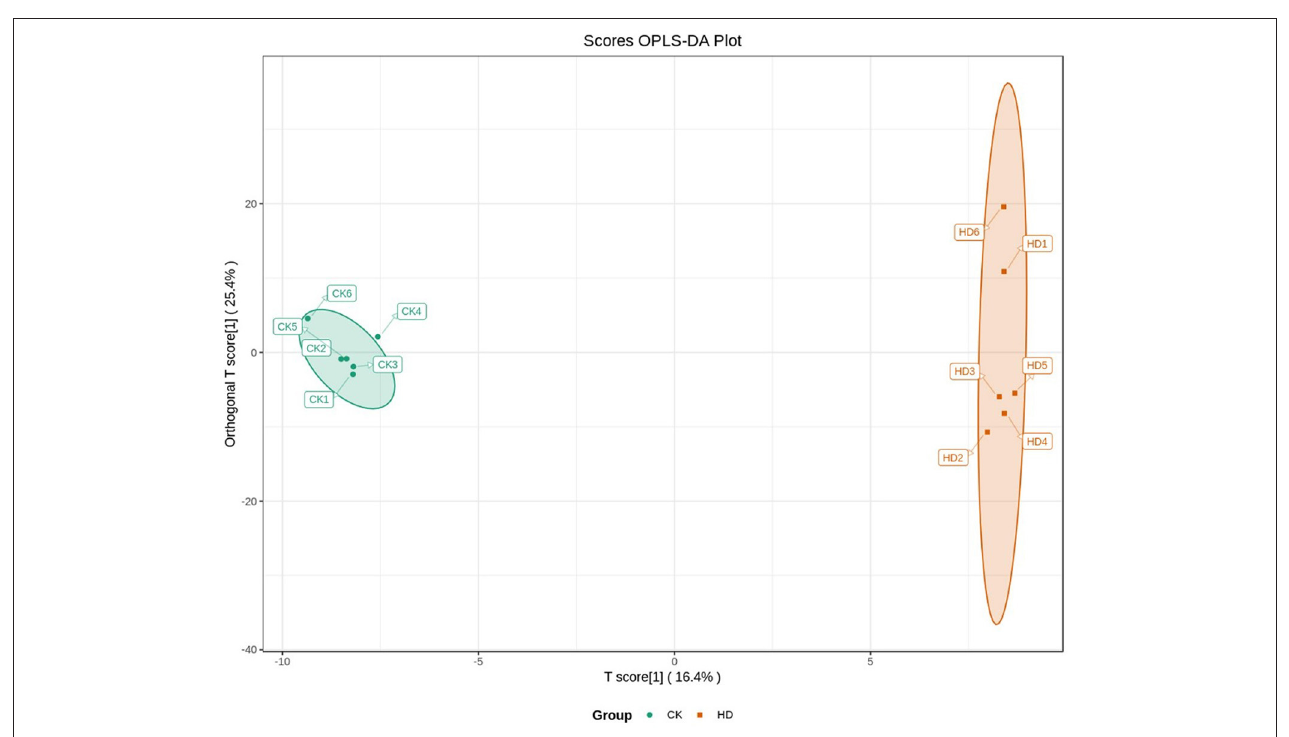
FIGURE 3 | Differences brain metabolite between treatment groups in mice analyzed by